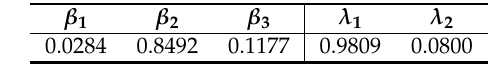
Table 2. Parameters of memory weight and the cumulative QoE model.